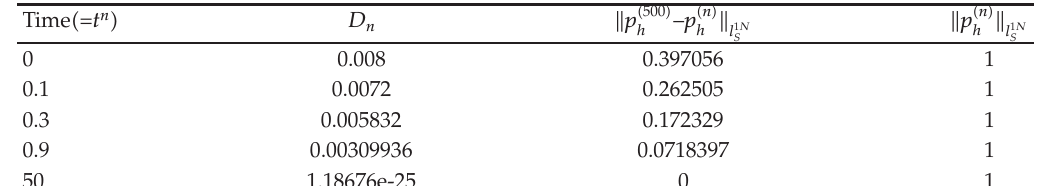
Table 4: Numerical results: Subcase 4.